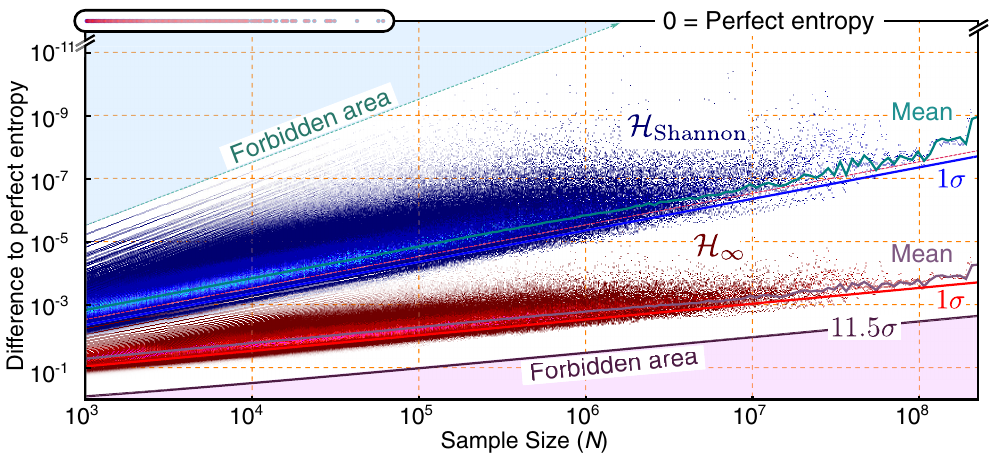
FIG. 4. Final entropy in the generated bit stream. The difference of the entropy ( H ) to unity is shown for the Shannon entropy (blue) and min entropy (red) against the sample size ( N ). A higher density and brighter color of the points obtained from experimental data signifies more outcomes of a certain value. The best possible case is a difference of 0, as displayed after a cutoff of the logarithmic scale on top of the graph. For N < 10 5 , sequences possessing this “ perfect ” entropy are still observed, shown as separate points. If a specific single bit is flipped, the entropy is reduced below unity. Subsequently, points in the graph that do not exhibit unity entropy cannot be higher than a certain limit (dashed curve). This forms a forbidden area to the top with no mathematically possible outcome. The solid straight line at the bottom indicates the conservative bound. These bounds are obtained a priori by an error propagation on the entropy of a fair coin, as outlined in the Supplemental Material [40]. Red: 1 σ deviation from the expected min entropy. Purple: Assuming an outlier probability of 2 − 100 . As expected, no values are found below this